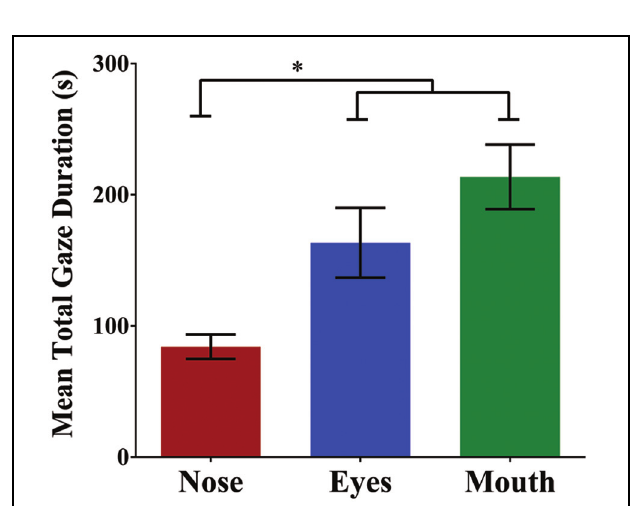
FIGURE 4 | Mean total gaze duration (seconds) for each of the three facial regions. Gaze duration on the mouth and eyes was significantly greater than the nose. Error bars denote ± 1 SEM. ∗ denotes significance at 0.05